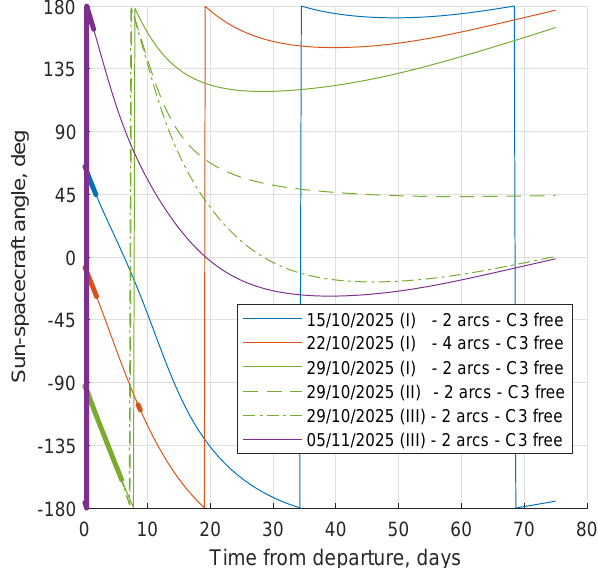
Figure 15. Time evolution of Sun–spacecraft relative angle for selected EML2 solutions.